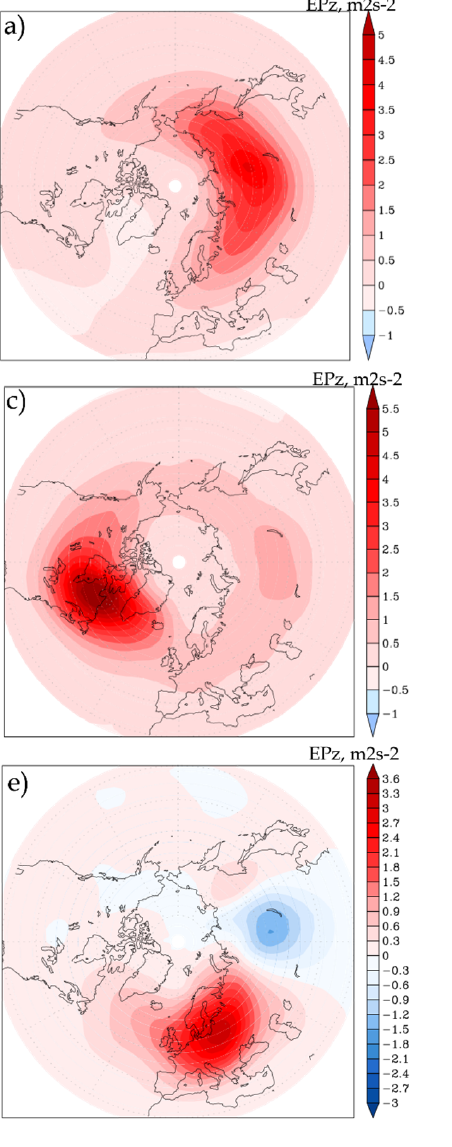
Figure 6. The dominant spatial patterns of absolute ↑ EPz m : ( a ) Asian, ( b ) European, ( c ) Canadian–Greenland; and absolute ↓ EPz m , ( d ) Canadian–Greenland, ( e ) Asian, ( f ) European during 1981–2020 in the Northern Hemisphere (30–90 °N) at 30 km height.